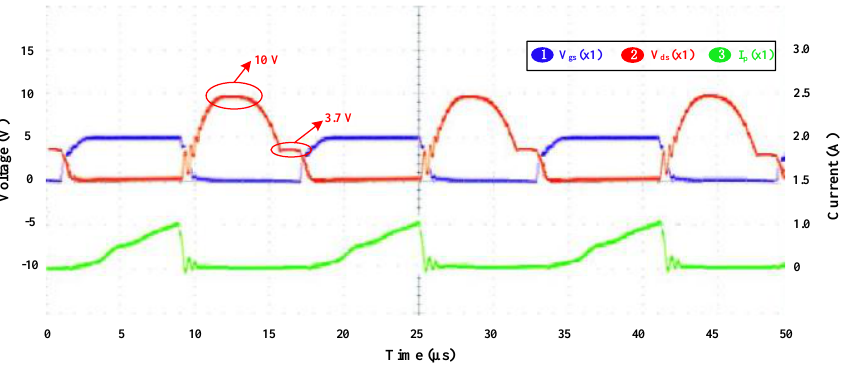
Figure 12. Node waveforms of the flyback converter.